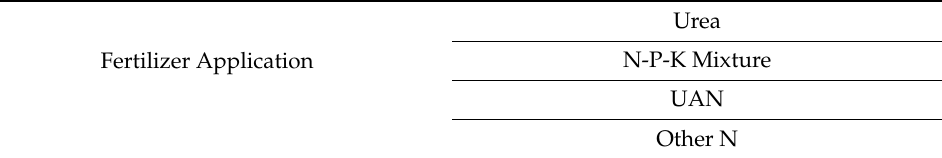
Table 3. The classification system of fertilizer-use agricultural land emission sources used in Korea.